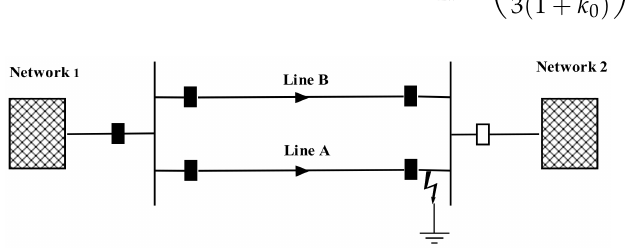
Figure 5. Both circuits in parallel operation fed from a single source.